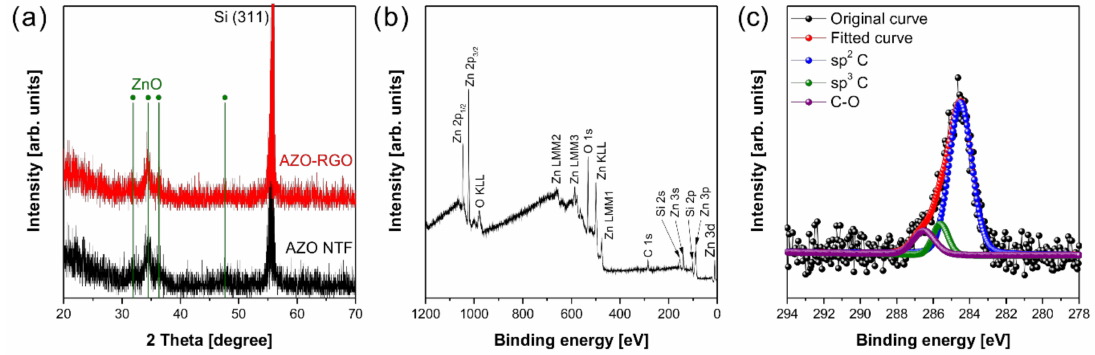
Figure 2. ( a ) XRD spectra of Al-doped ZnO thin film (AZO TF) and AZO-reduced graphene oxide (RGO) NCTF. ( b ) XPS wide scan and ( c ) C1s core level spectra of AZO-RGO nanocomposite thin film